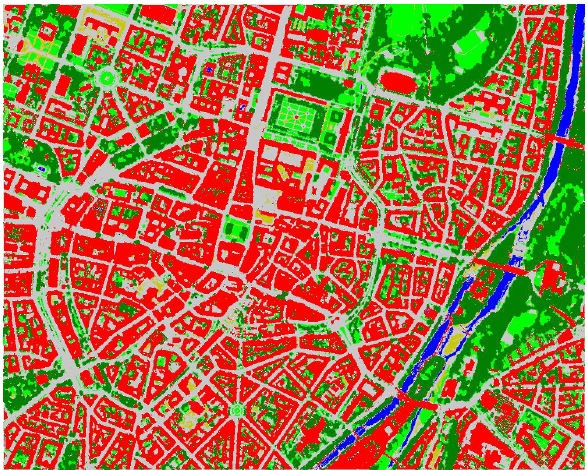
Figure 9. Fused classification Munich, 2500 m × 2000 m, red: buildings, dark green: trees, green: grass, blue: water, brown: soil, gray: roads/sealed surfaces stereo pair were 0.01/11.01 and 0.02/5.66 degree. So both scenes were acquired from north. The sun-azimuth and -elevation were 54 and 50 degree. For the example a section of 2500 × 2000 me- tres (left top edge: 144 . 9477391376 ◦ E, − 37 . 8089806144 ◦ S, ground sampling distance 0.5 m) of the center of Melbourne was choosen as shown in fig. 10.